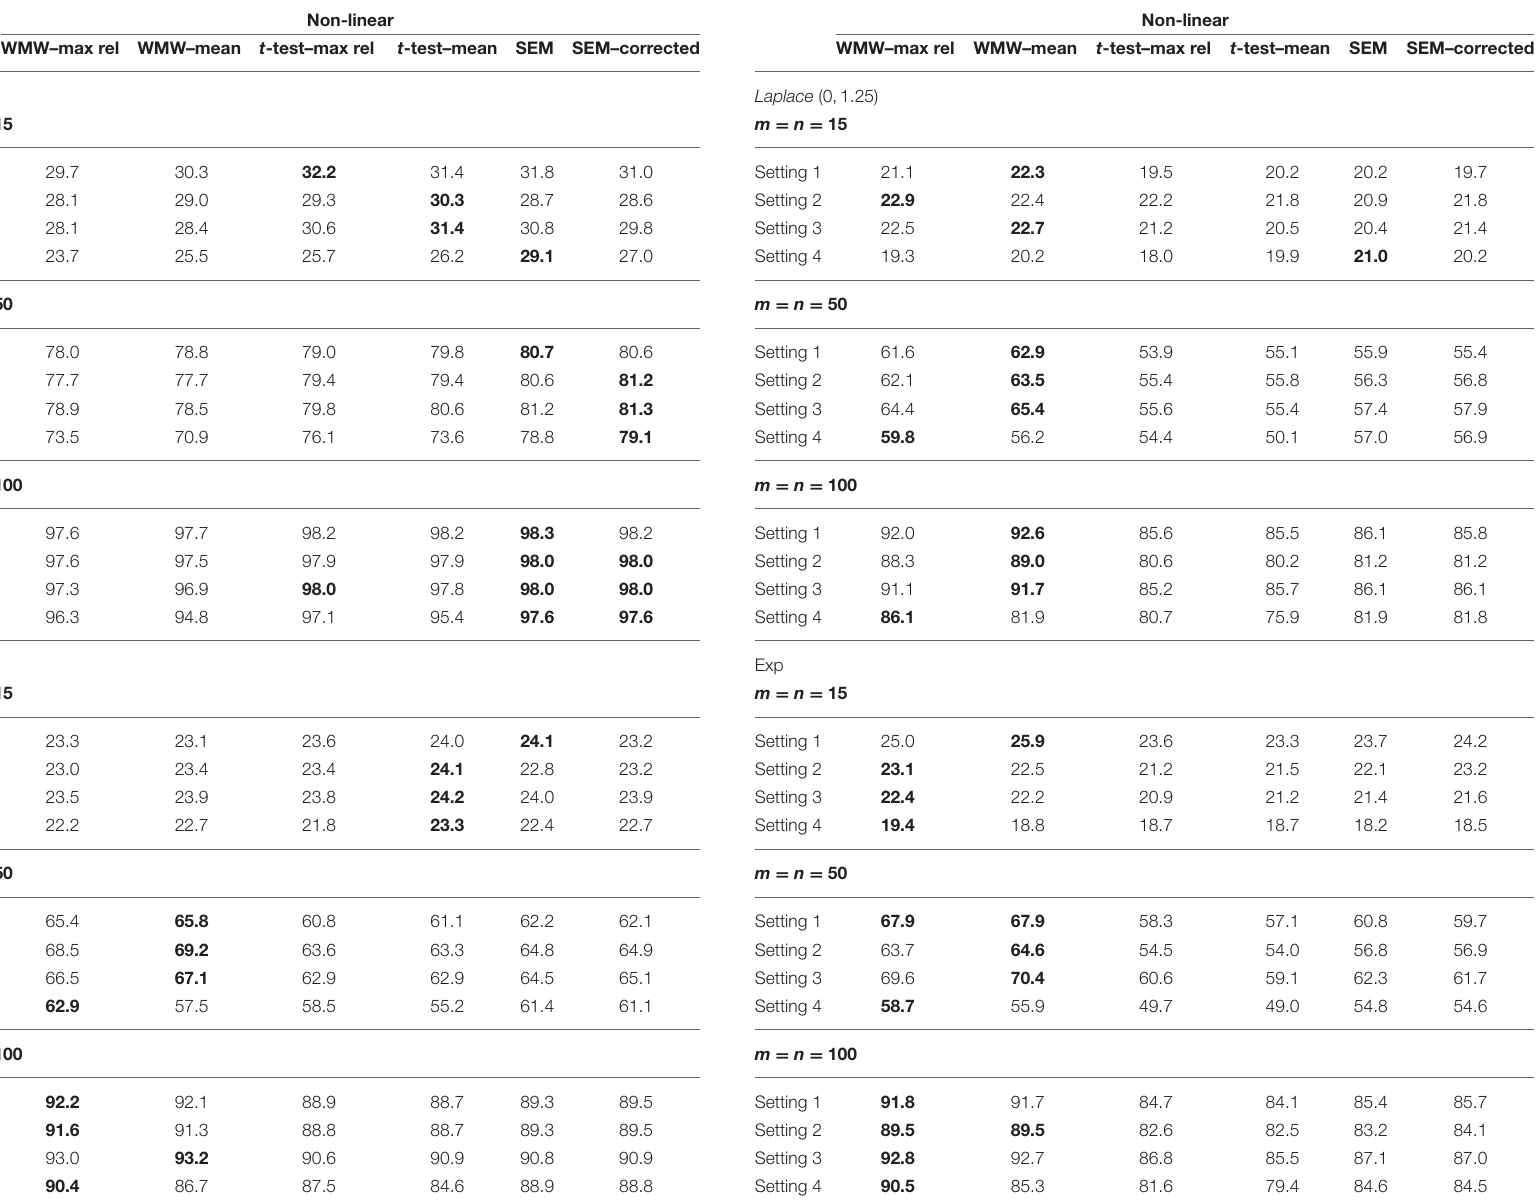
The highest power per setting is indicated in